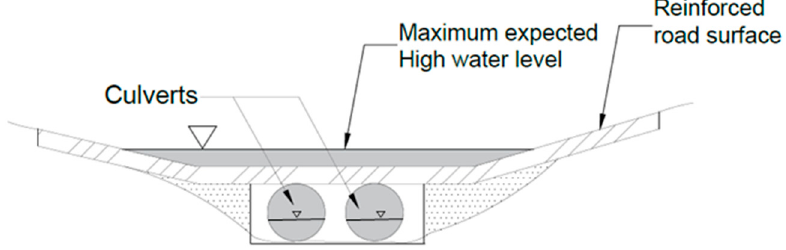
Figure 2. Schematic of a vented ford.